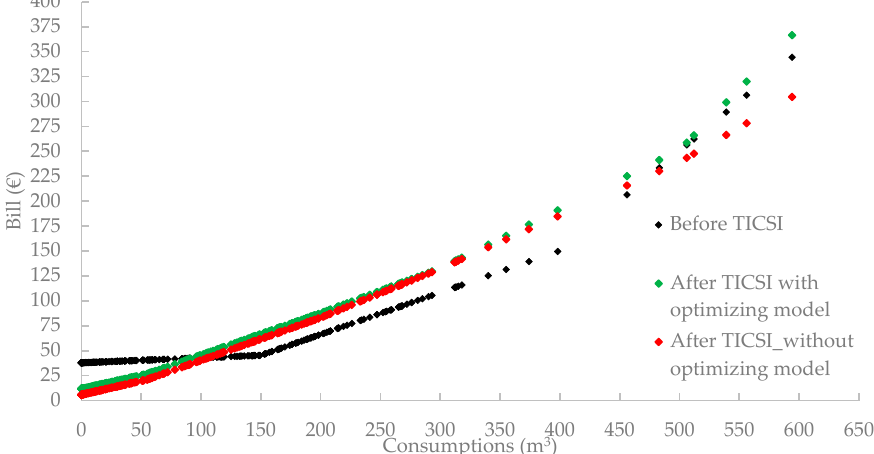
Figure 5. The trend of payments as the volumes of water consumed change.